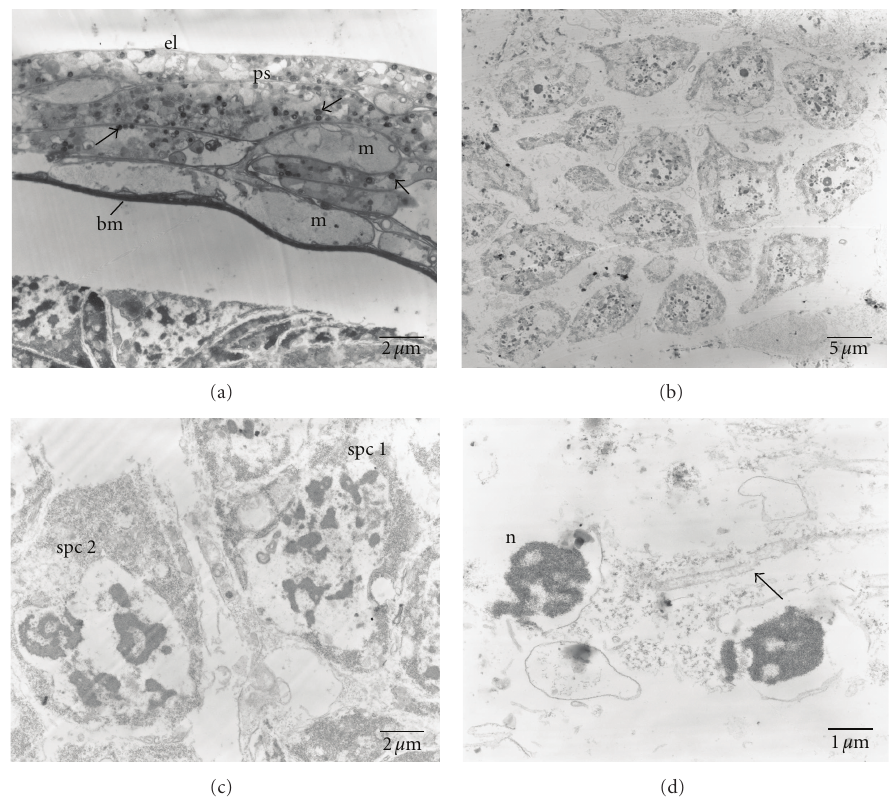
Figure 4: TEM micrographs of the testis of a 3-day-old C. megacephala. (a) Transverse section showing the strata forming the testicular wall formed by an external layer (el), a peritoneal sheath (ps), a muscular layer (m), and a basement membrane (bm). Rounded grains containing pigment, with varying density levels, are spread in the cytoplasm (arrows). (b) Germ cells showing group of pear-shaped cells. (c) Primary spermatocyte (spc 1) with packed electron-dense chromatin and secondary spermatocyte (spc 2) which is characterized by four groups of separated nuclei. (d) Spermatozoa with nuclei (n) and flagellum